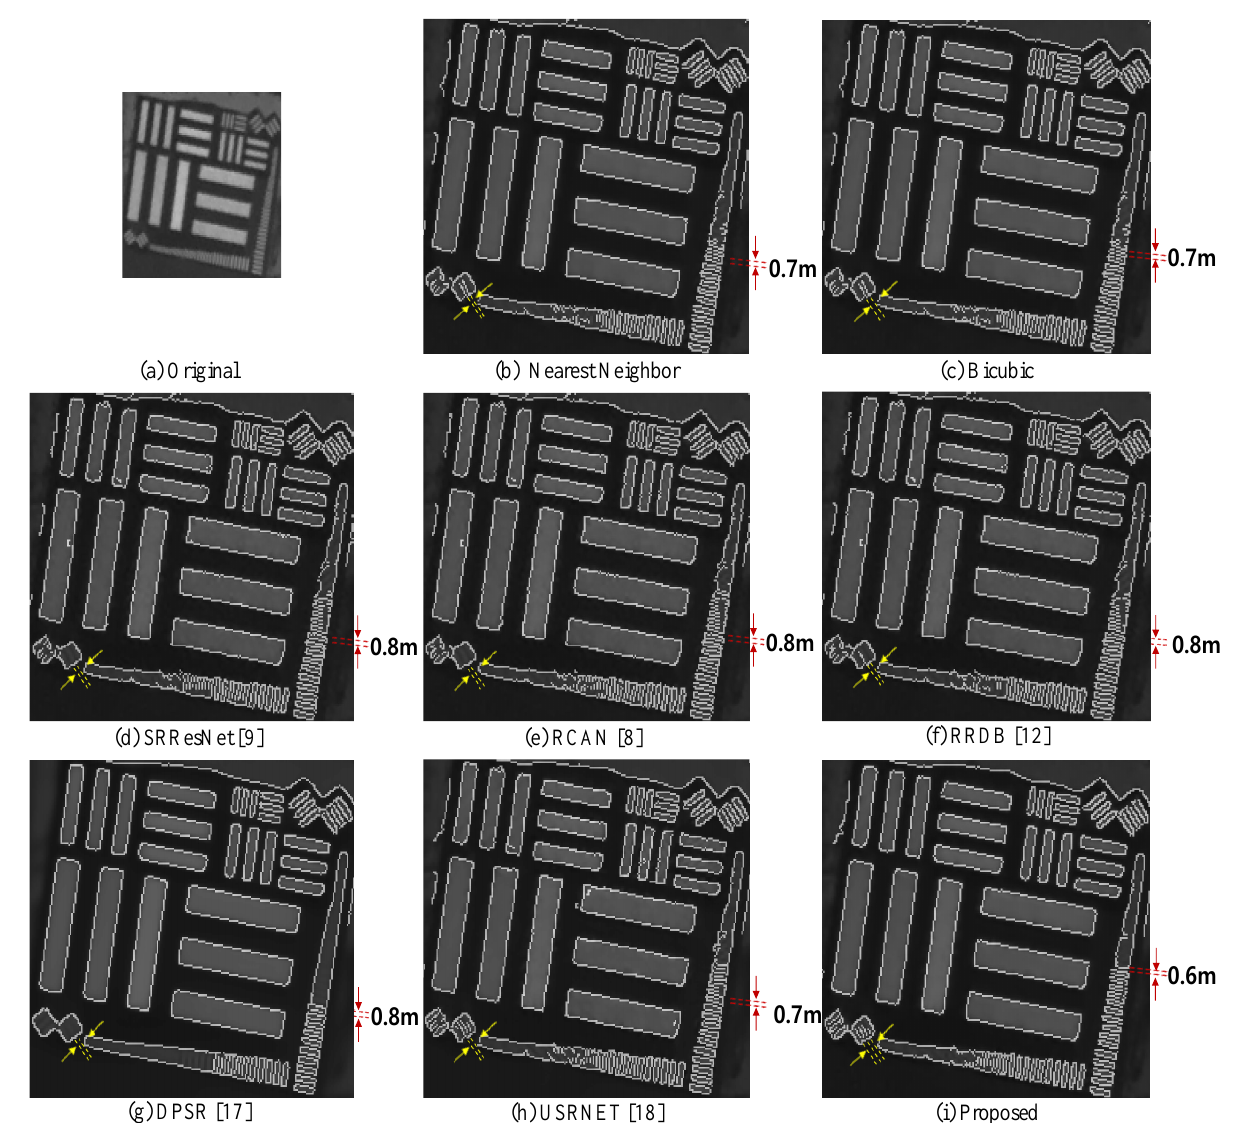
Figure 14. Bar-pattern target SR results: ( a ) Original, ( b ) Nearest Neighbor, ( c ) Bicubic, ( d ) SRResNet, ( e ) RCAN, ( f ) RRDB, ( g ) DPSR, ( h ) USRNET, ( i )